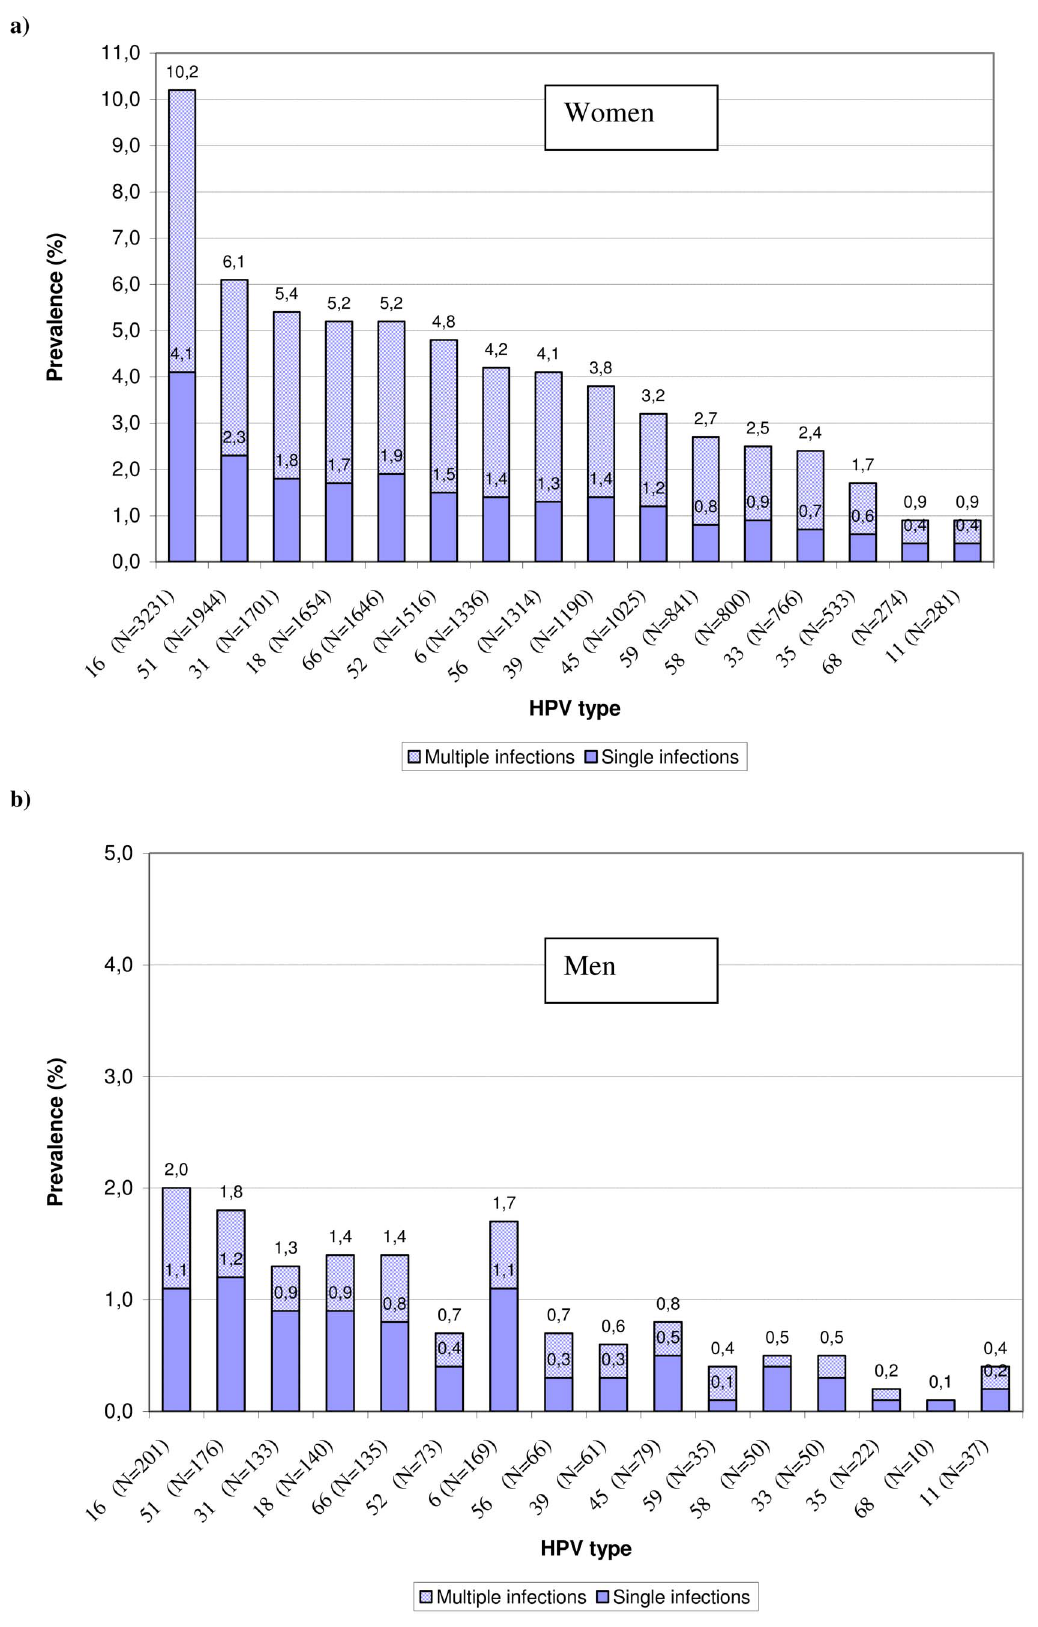
Figure 1. Type-specific human papillomavirus prevalence in samples from women (a) and men (b), Sweden.